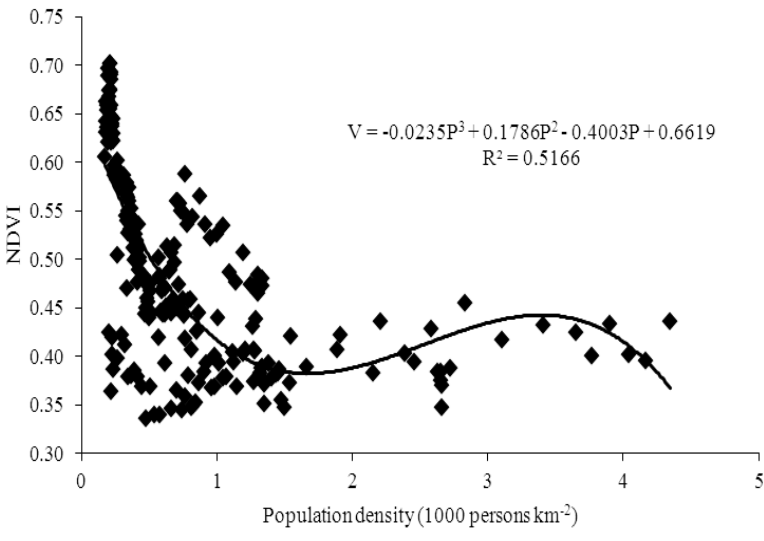
Figure 6. The scatterplot of population density and NDVI with fitted curve in high-urbanization cities from 1982 to 2006.